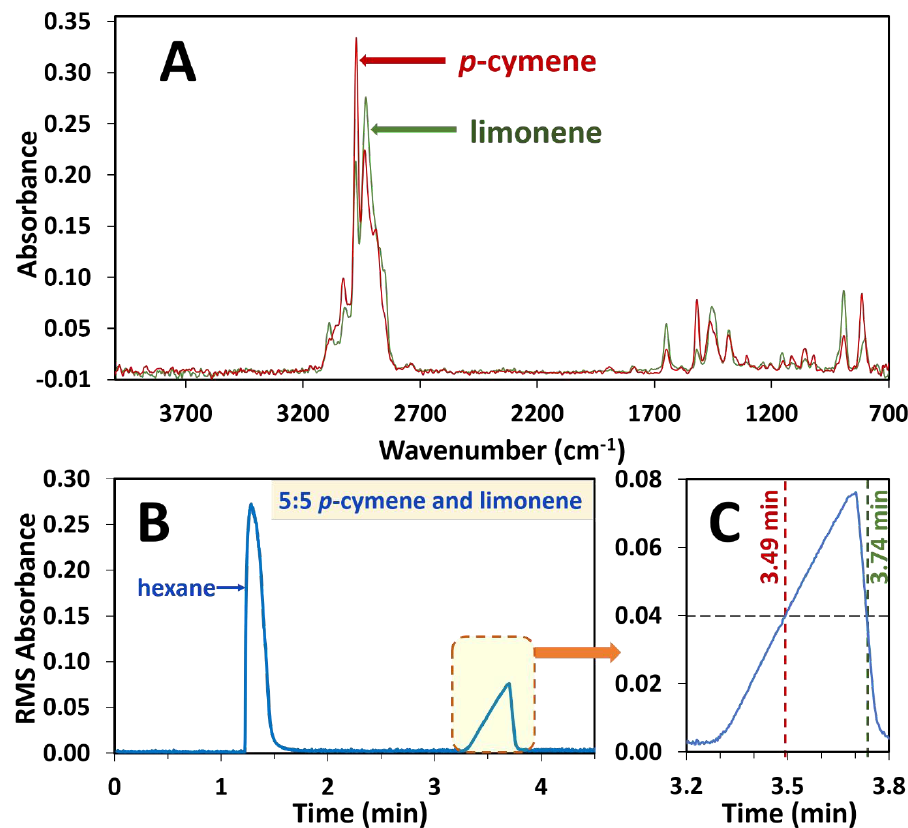
Figure 2. Depiction of extraction of spectra at 0.04 RMS absorbance intensity of the single unresolved chromatographic peak due to co-eluting components in a 5:5 ratio mixture of p -cymene and limonene essential oil standards. p -cymene and limonene often overlap on GC columns and are deliberately overloaded here to illustrate the power of FTIR to deconvolute overlapping peaks. ( A ) Spectrum of p - cymene at 3.49 min and spectrum of limonene at 3.74 min, both at 0.04 RMS absorbance. ( B )